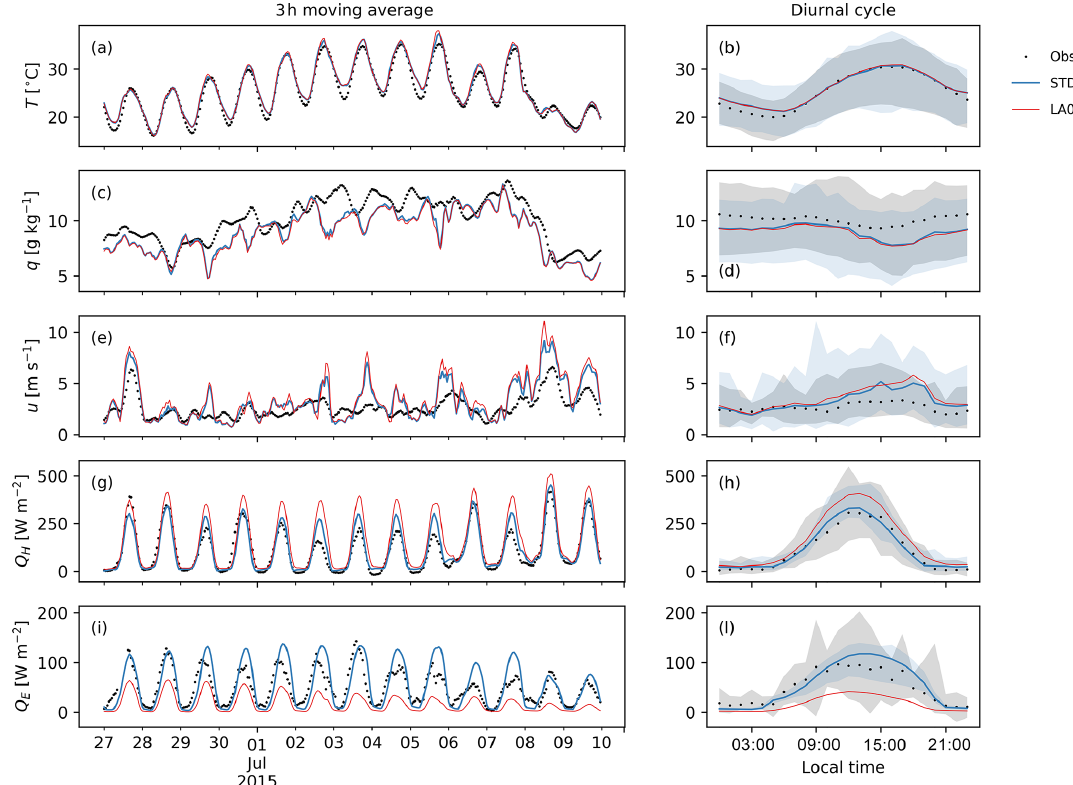
Figure 5. Comparison between observations (Obs) and model simulations (STD, LA0) of air temperature (a, b) , specific humidity (c, d) , wind speed (e, f) , sensible heat flux (g, h) and latent heat flux (i, l) at the BKLI site (38m tall flux tower) during the study period. The left (a, c, e, g, i) and right (b, d, f, h, l) columns show the 3h moving average and the diurnal cycle, respectively. Black dots indicate the observations. Blue lines and red lines indicate the results from the STD and LA0 model runs, respectively. The shaded areas represent the range of variability within the period for the observations and STD simulation only. Specifications of the model setups can be found in Sect.